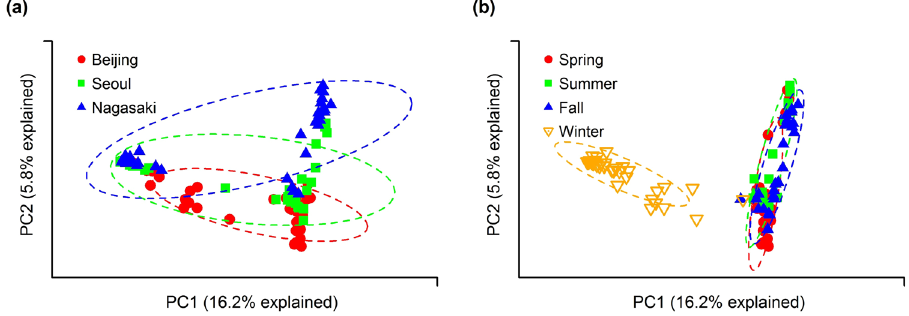
Figure 5. Principal component analysis (PCA) at the OTU level based on the Bray-Curtis distance for all measurement samples. Samples are grouped ( a ) by city and ( b ) by season.